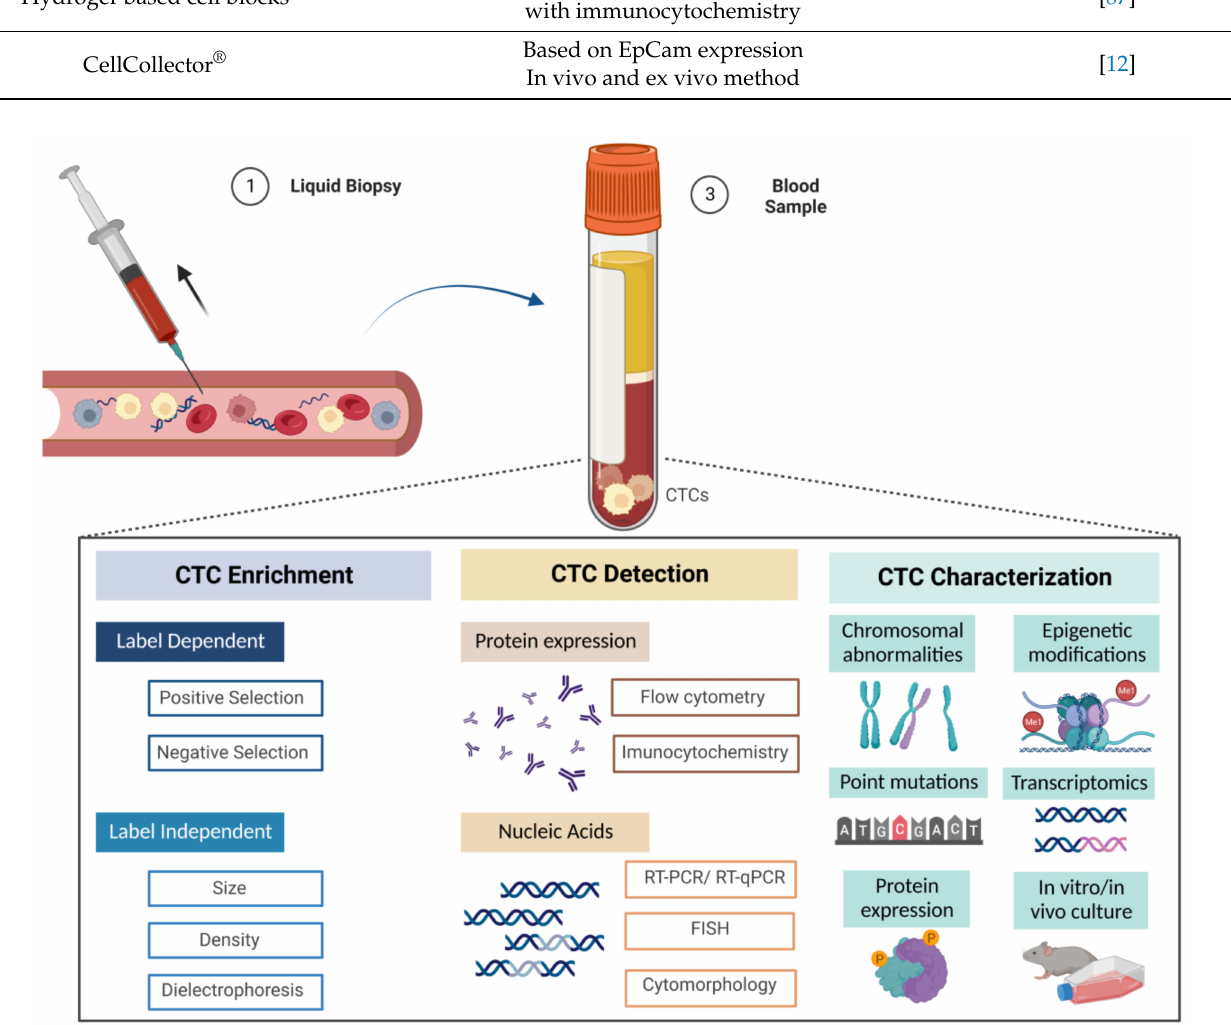
Figure 2. Schematic diagram of the steps involved in RCC-CTCs processing after blood collection: firstly, there is the step of CTC enrichment that can be achieved through various techniques;